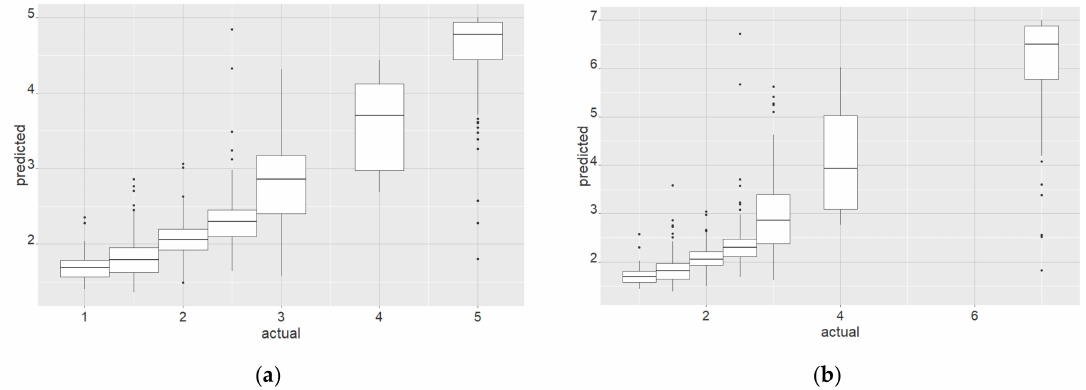
Figure 10. Boxplot for the predicted and actual values from an RF regression on the seven-level reference scheme for crowns with a diameter larger than 4 m (total 895). Figure ( a ) shows the basic scale from 1 to 5 and figure ( b ) presents the results after rescaling the value 5 for “dead” tree crowns to 7.